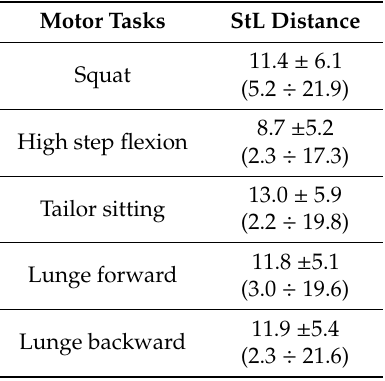
Table 3. Stem-to-liner (StL) distance (in mm) from the 3D VA; the mean ± standard deviation value from all patients, along with (min ÷ max) values, are